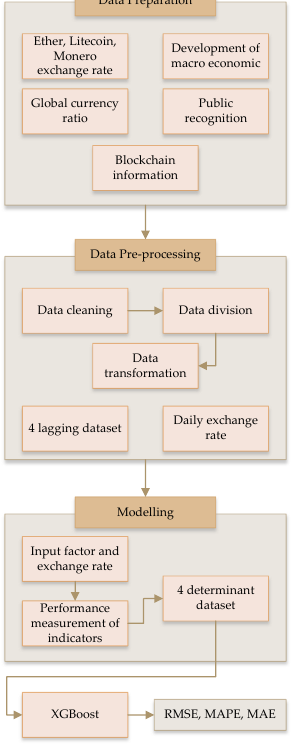
Figure 1. Overview of the employed model in this